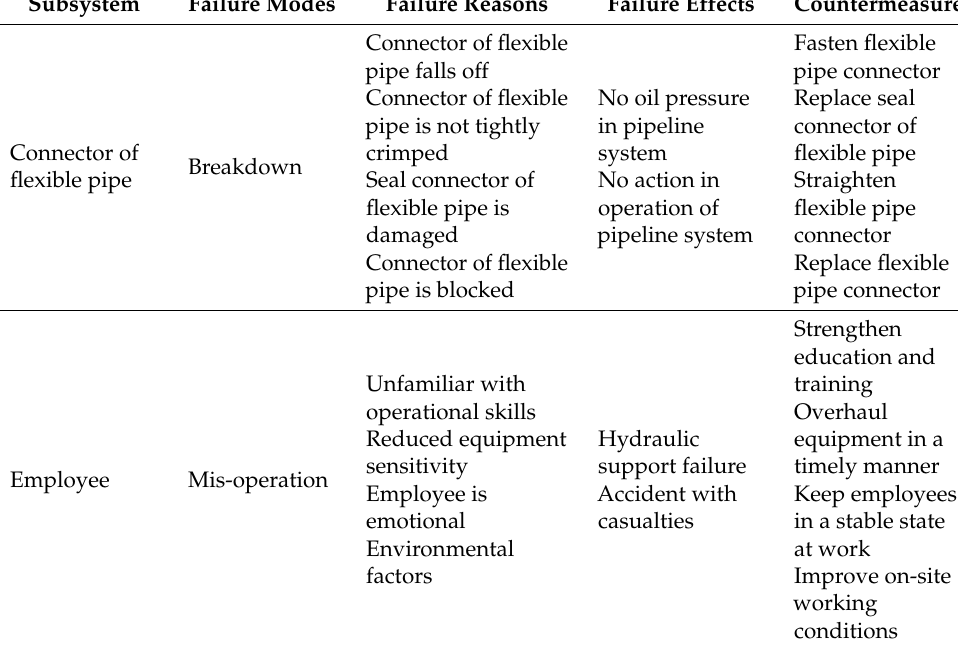
Table 4. FMEA of hydraulic support